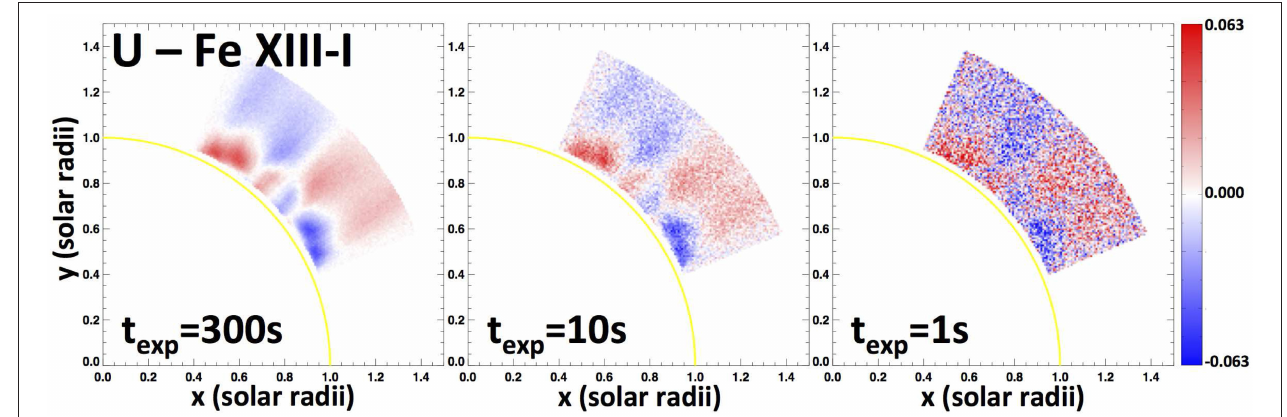
FIGURE 10 | Synthetic Stokes U images of the ground truth for different exposure times, t exp , and hence, noise levels.